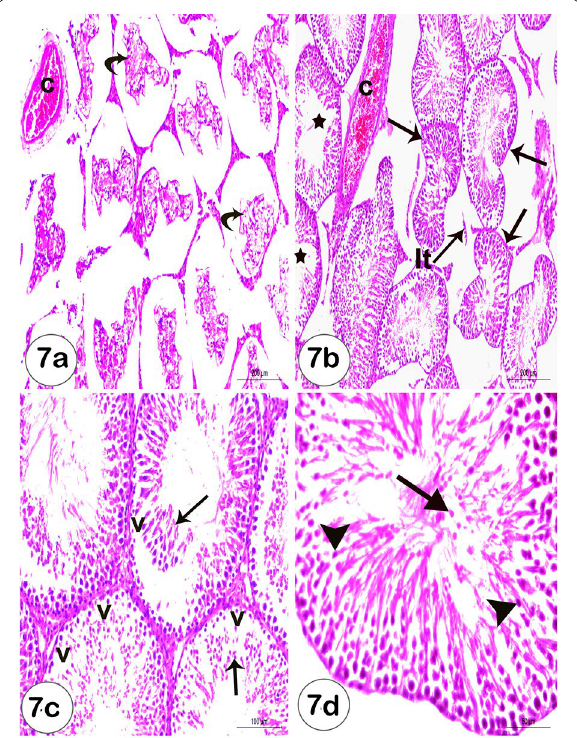
Fig. 7 a–d Photomicrographs of a sections of testis of MSG‑treated male rats showing ( a ) Irregular, shrinked and disorganized structure and remainant of damaged seminiferous epithelium (curved arrows) and congested blood vessel ( c ) (Scale bar 200 µm). b Degenerated = interstitial tissue (it), irregular variable‑sized seminiferous tubules(arrows) and many tubules (star) showed a decrease in the number of spermatogenic cells to a few layers and few or no sperms were observed (Scale bar 200 µm). c Detachment of germ cells = from basal lamina (arrows) and cytoplasmic vacuolation (v) (Scale bar 100 µm). d Pyknosis of nuclei (arrow head) and sloughing of = spermatogonia cells into the lumen of seminiferous tubules (arrow) (Scale bar 50 =